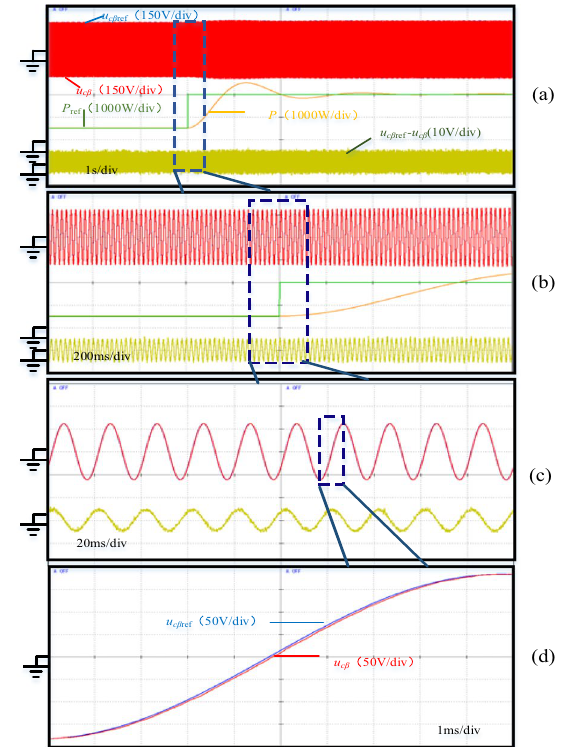
Fig. 14 Experimental waveforms during sudden change of active power without error compensation. a 1 s/div. b 200 ms/div. c 20 ms/ div. d 1